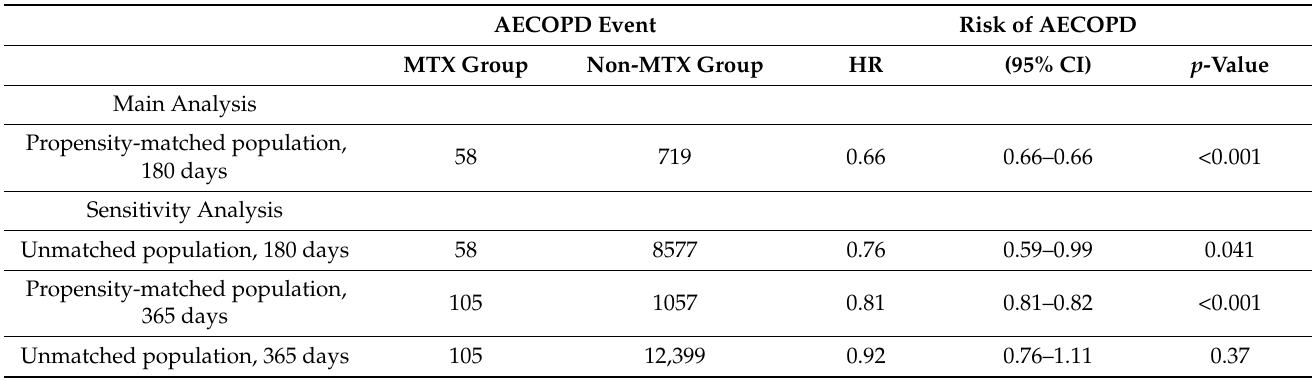
Figure 3. Sensitivity Analyses—Cumulative Incidence of AECOPD. ( a ) Cumulative incidence of AECOPD in MTX users and non-MTX users in the unmatched population at 180-day follow-up. MTX was associated with lower risk of hospitalization-requiring COPD exacerbation (HR 0.76, CI 0.59–0.99, p = 0.04); ( b ) Cumulative incidence of AECOPD in MTX users and non-MTX users in the matched population at 365-day follow-up. MTX was associated with lower risk of hospitalization-requiring COPD exacerbation (HR 0.81, CI 0.81–0.82, p < 0.001); ( c ) Cumulative incidence of AECOPD for MTX users and non-MTX users in the unmatched population at 365-day follow-up. MTX was associated with lower risk of hospitalization-requiring COPD exacerbation (HR 0.92, CI 0.76–1.11, p = 0.37). COPD, Chronic Obstructive Pulmonary Disease; AECOPD, Acute hospitalization-requiring exacerbation of COPD; MTX, Methotrexate; HR, Hazard ratio; CI, Confidence interval. Table 2. Risk of AECOPD for the propensity-matched population and the unmatched